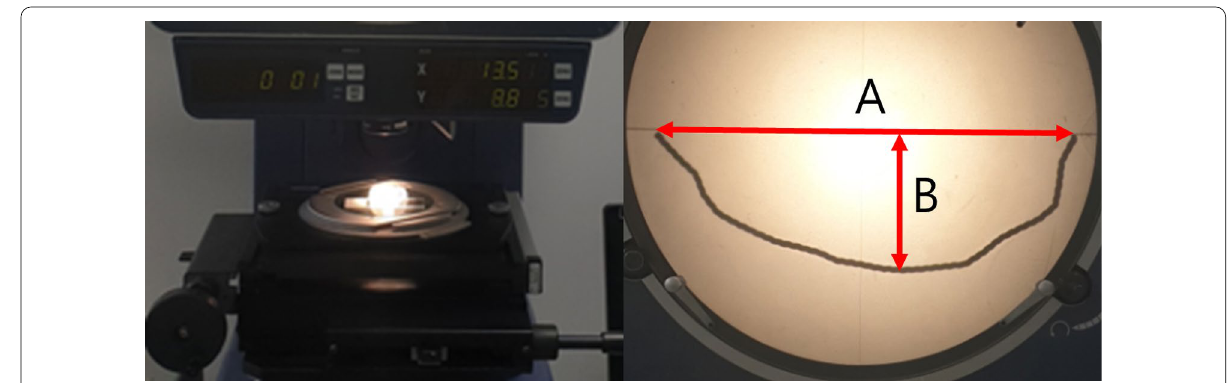
Fig. 7 Measurement of LW and AP using profile projector. A Lateral width. B Anteroposterior